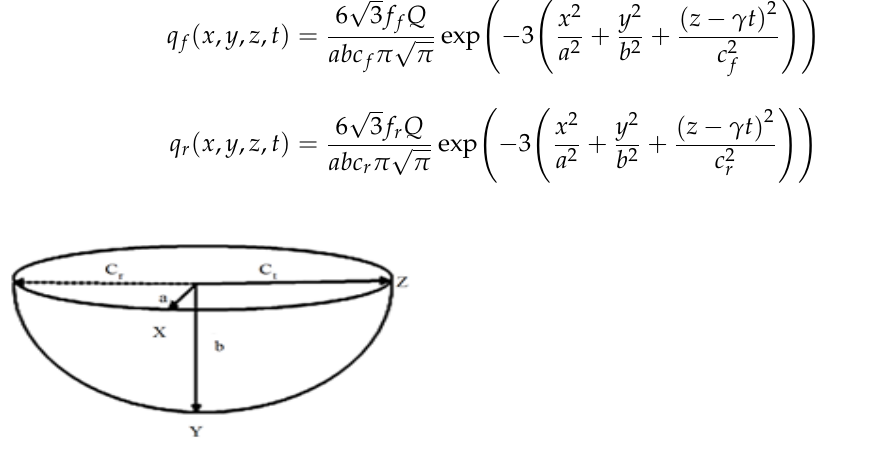
Figure 2. Temperature-dependent material properties of STS304: ( a ) physical properties; ( b ) me- chanical properties.